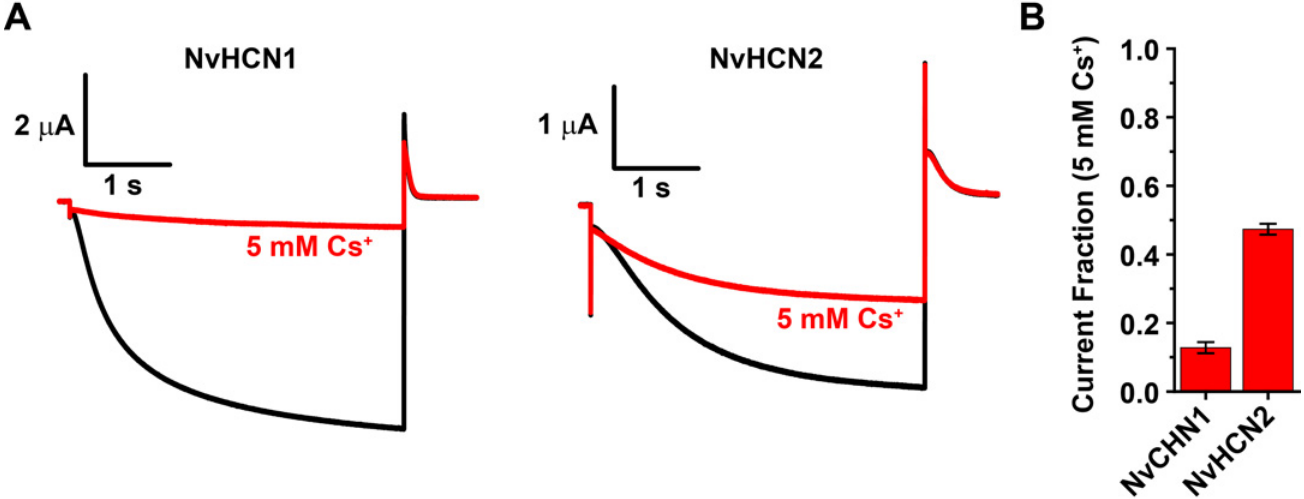
Fig 4. Cs + block of NvHCN1 and NvHCN2. (A) Current traces recorded at -100 mV from oocytes expressing NvHCN1 or NvHCN2 before (black) and after (red) application of 5 mM Cs + to the bath. The holding potential was -30 mV and outward tail currents were recorded at 0 mV. (B) Fraction of current remaining after application of 5 mM Cs + for NvHCN1 and NvHCN2. Data show mean ± S.E.M. (n = 6 and 7 for NvHCN1 and NvHCN2, respectively).